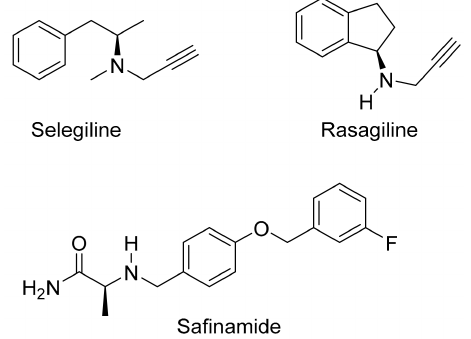
Figure 2. The structures of selegiline, rasagiline and